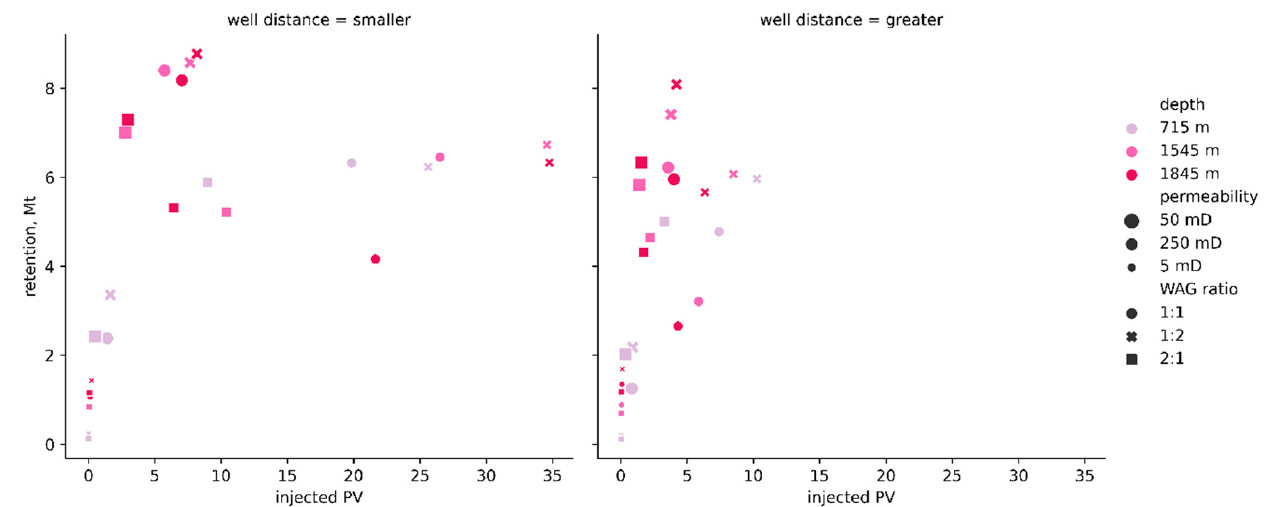
Figure 6. Retention versus injected pore volumes after 15 years of EOR.